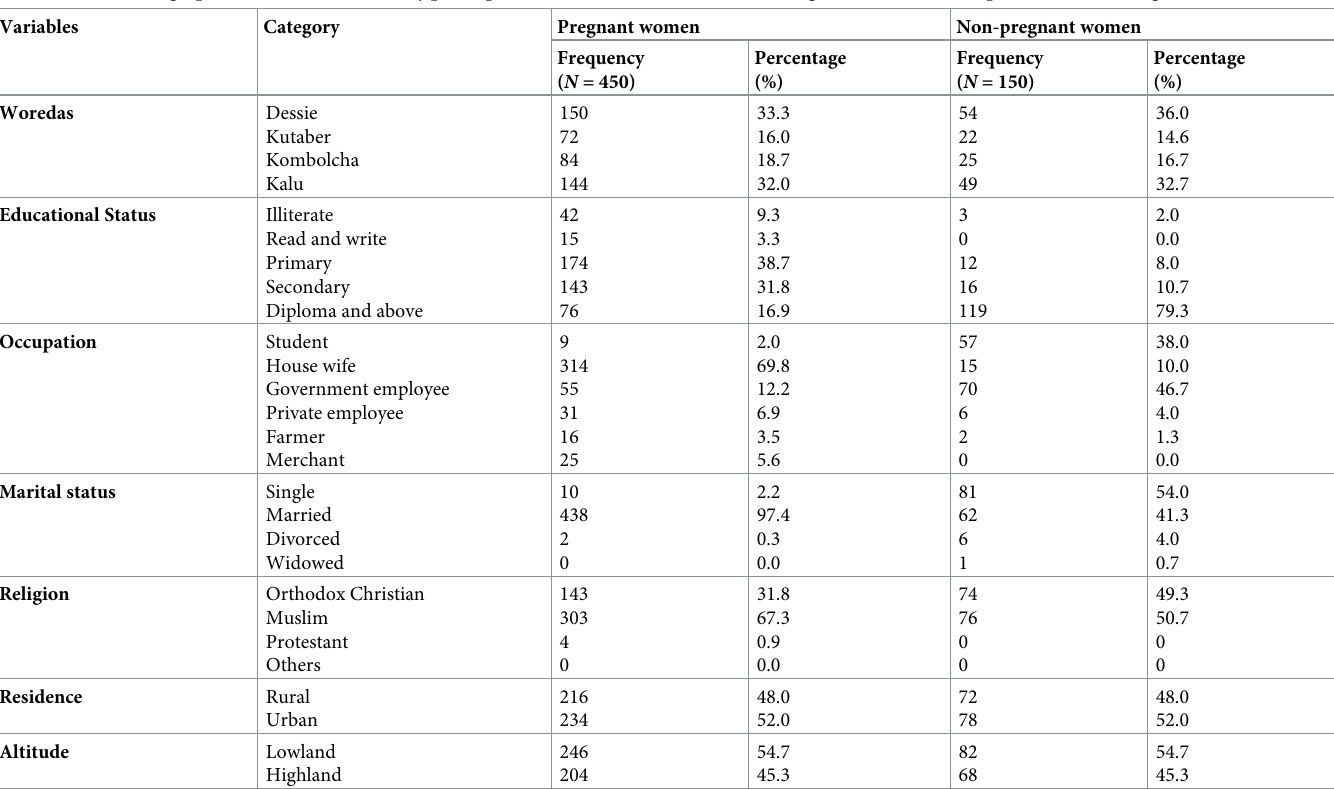
Table 1. Socio demographic characteristics of study participants in South Wollo zone, Amhara Region, Northeast Ethiopia from June to August, 2019.